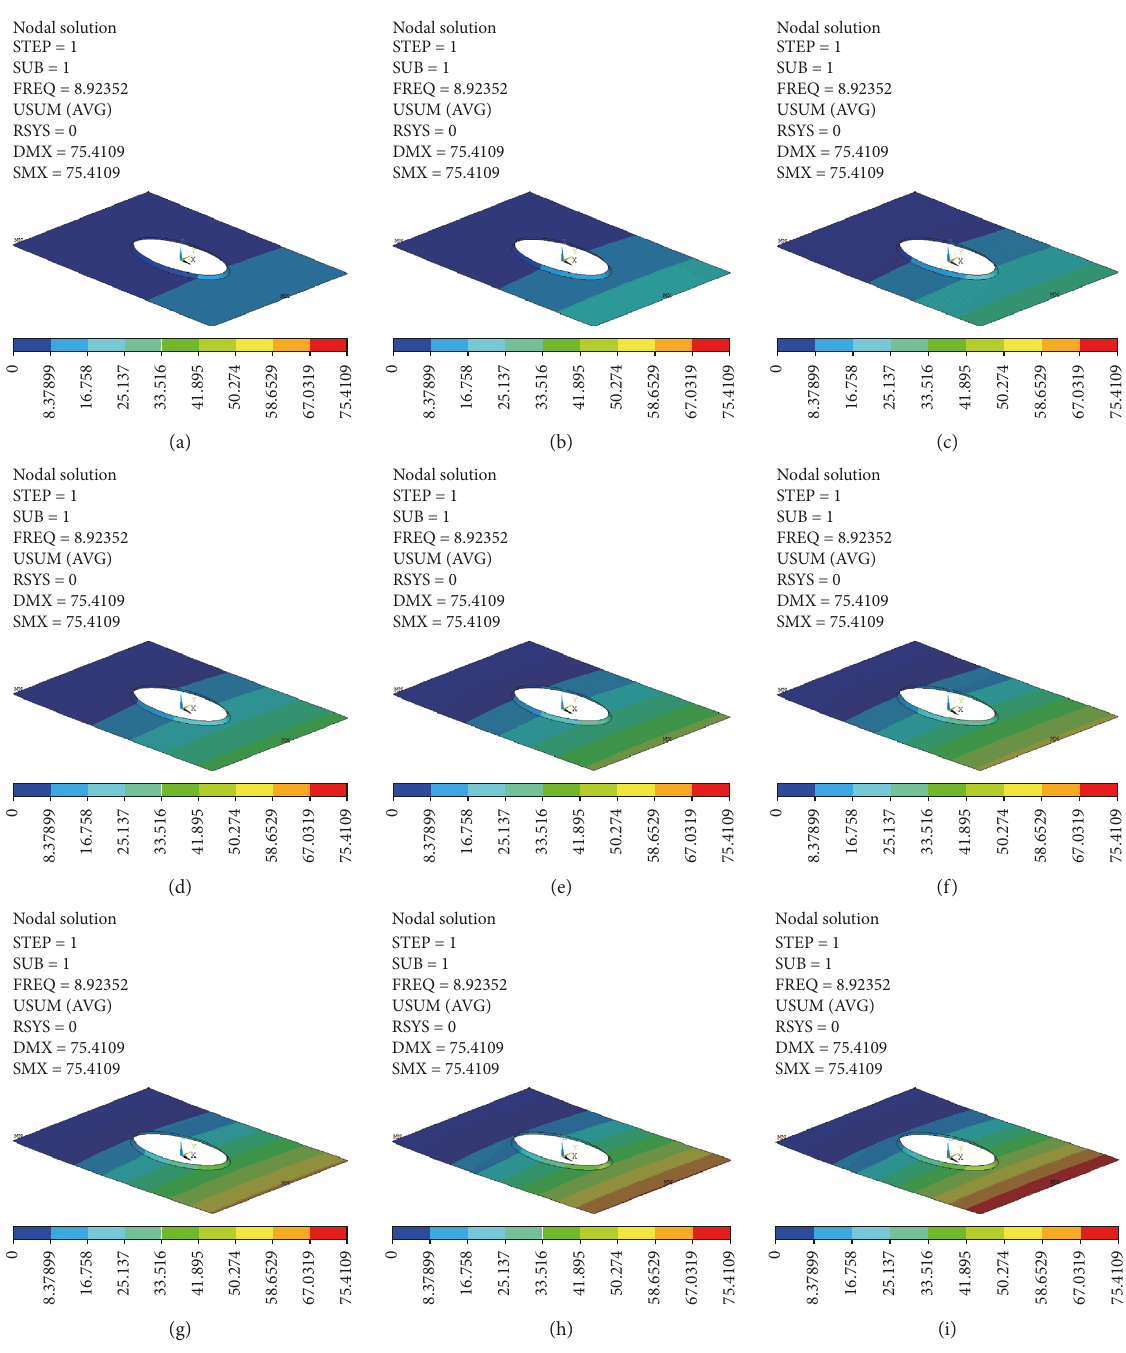
Figure 2: Oscillatory process of the plate for the first frequency in CFFF. (a) Time (e) Time 0.25. (f) Time (cid:31)